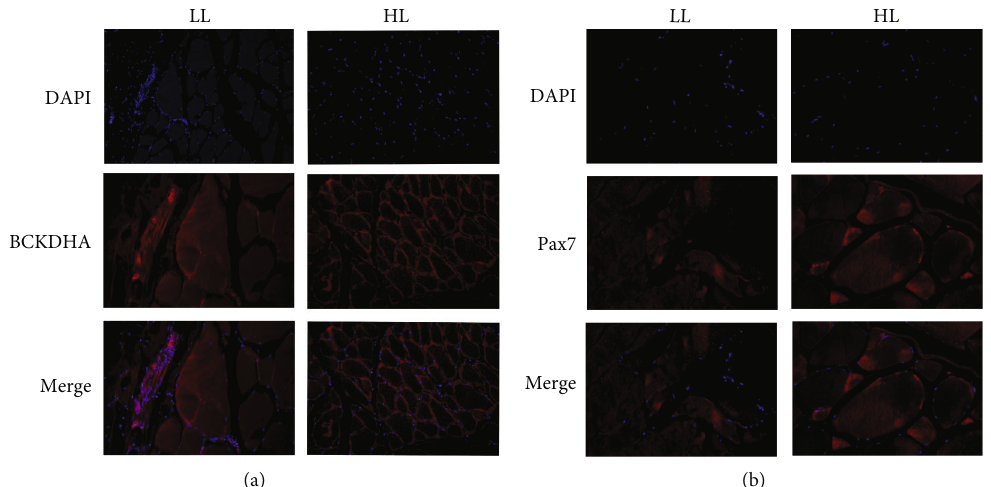
Figure 6: The location of BCKDHA and Pax7 in blunt snout bream white muscle fed the two kinds of trial diets (LL: fi sh fed LL diets; HL: fi sh fed HL